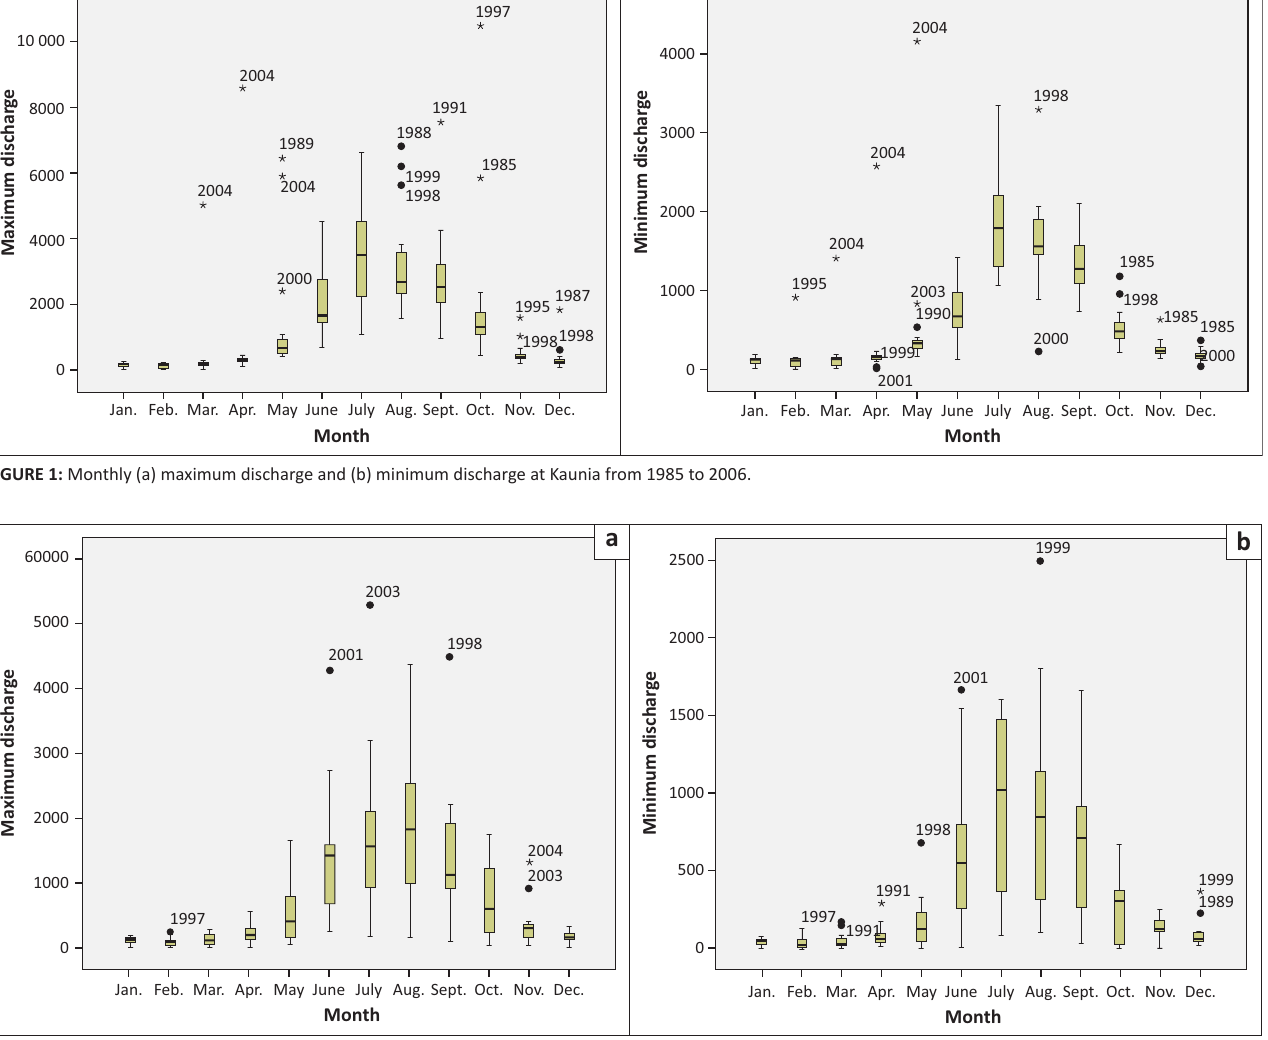
FIGURE 2: Monthly (a) maximum discharge and (b) minimum discharge at Dalia from 1985 to